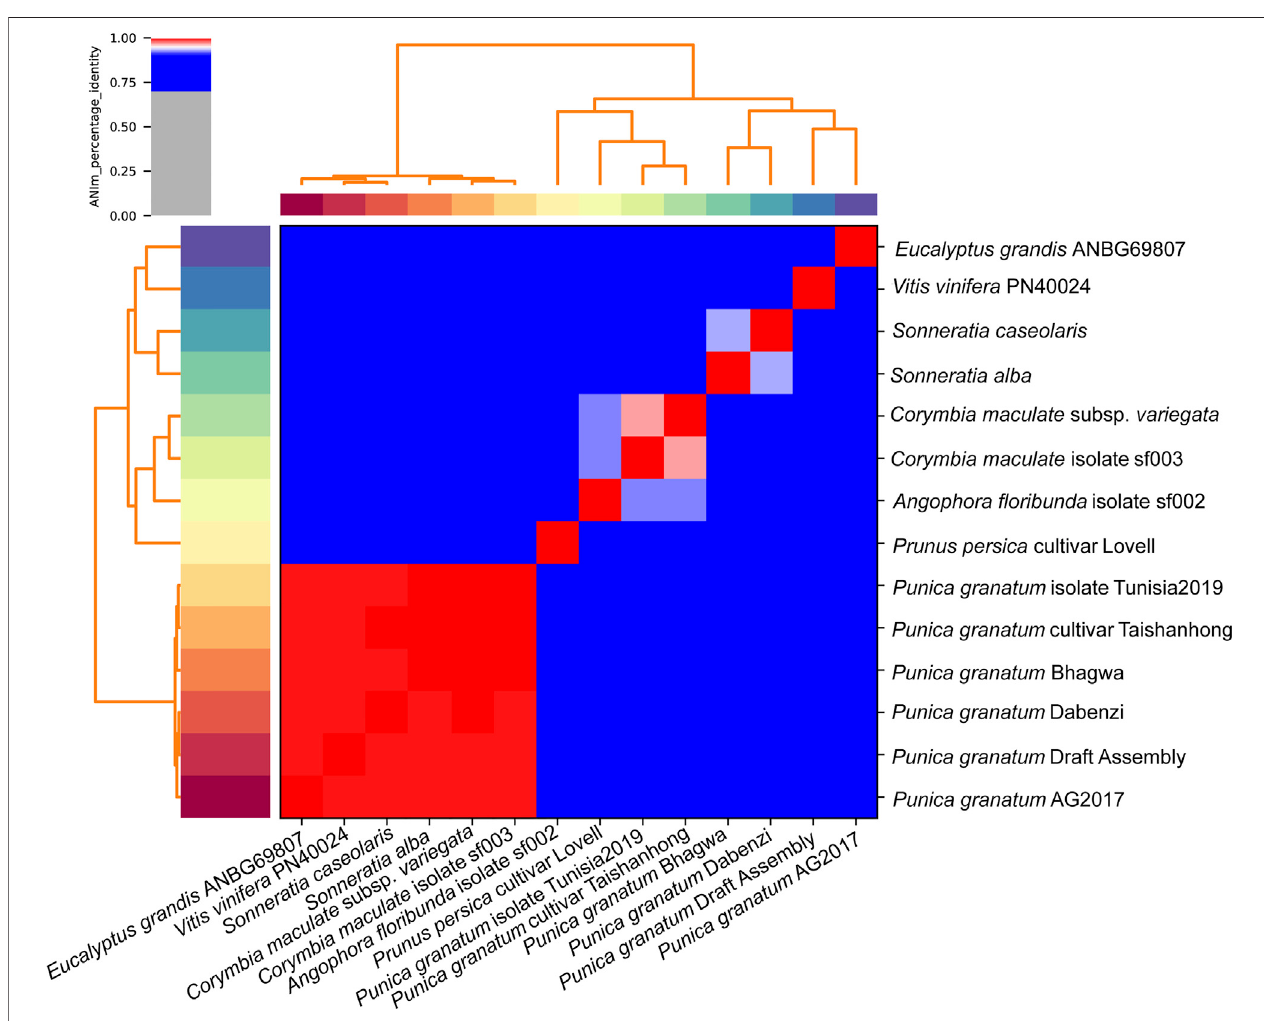
FIGURE7| Heatmap ofANImpercentage identity: species-levelassignmentsandisolate identi fi ersasindicatedat sourcegivenasrowand column labels. Cells in the heatmap corresponding to 95% ANIm sequence identity are colored red. Blue cells correspond to ANIm comparisons indicating that the corresponding organisms do not belong to the same species. Color intensity fades as the comparisons approach 95% ANIm sequence identity. Color bars above and to the left of the heatmap correspond to source species-level assignments for each isolate in the analysis. Hierarchical clustering of the analysis results in two dimensions is represented by dendrograms, constructed by simple linkage of ANIm percentage